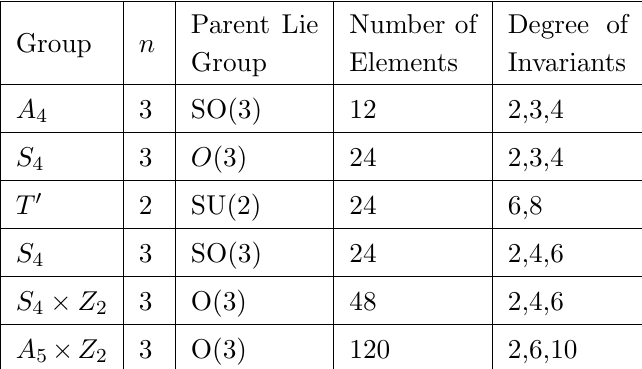
Z 2 is isomorphic to (cid:2)